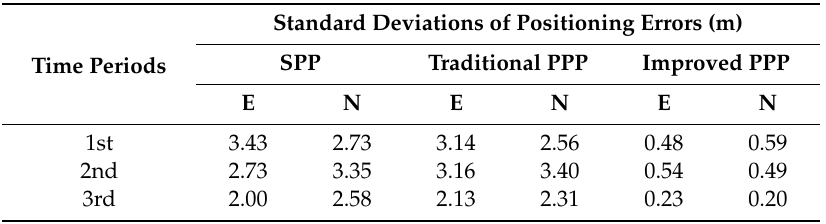
Table 4. The standard deviations of positioning errors in east (E) and north (N) directions.